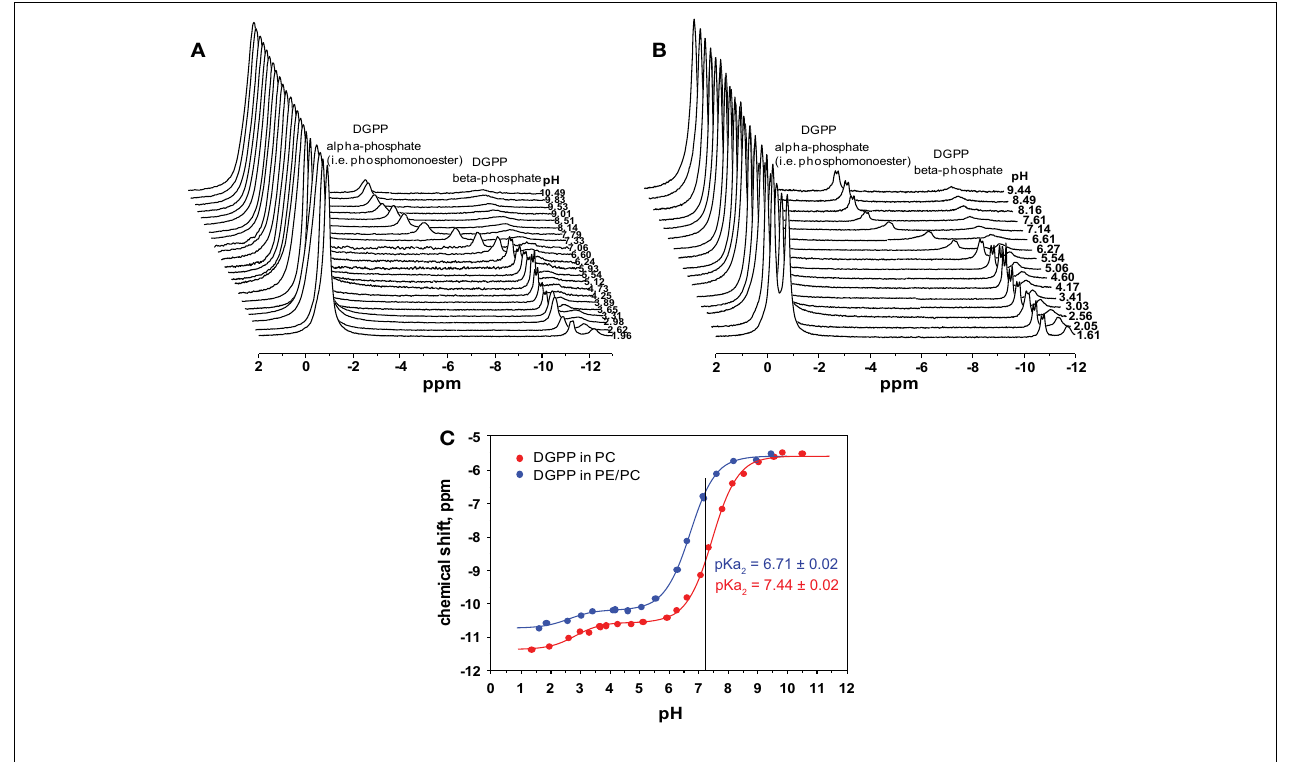
DGPP in DOPC (red curve) and 5mol% DGPP in DOPC–DOPE 1:1 (blue curve). Lines are best non-linear least squares fits to a Henderson–Hasselbalch type equation.